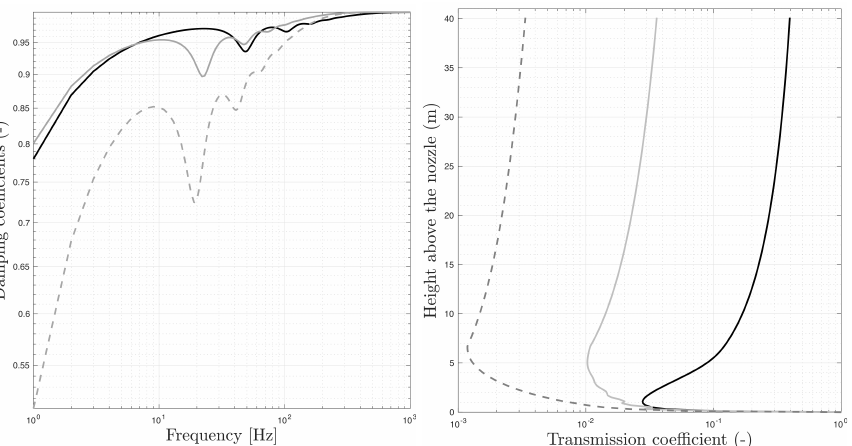
Figure 12. Prediction of the acoustic properties of the air bubble curtain: ( left ) the spectrum of transmission loss at three depths, in which the black solid line represents the results at 1 m above the nozzle, the gray solid line indicates the results at 5 m from the nozzle, and the gray dashed line indicates the results at 20 m from the nozzle; ( right ) damping coefficients for three different frequencies over the depth, in which the black solid line, the gray solid line, and the gray dashed line represent f = 20, 150, 300 Hz,